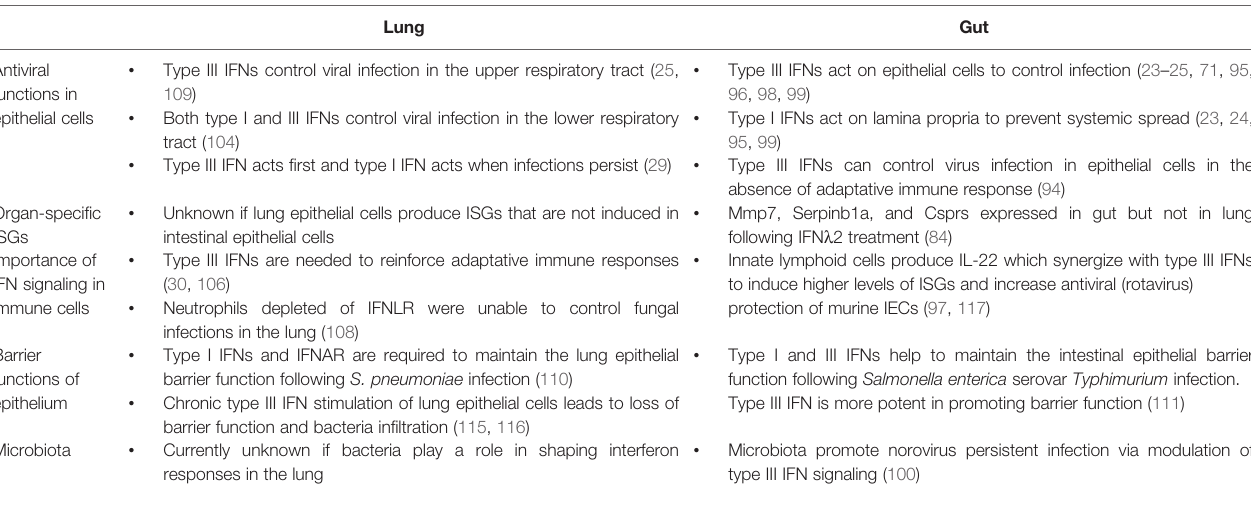
TABLE 2 | Role of type I and III IFNs in respiratory and intestinal epithelial cells. Lung